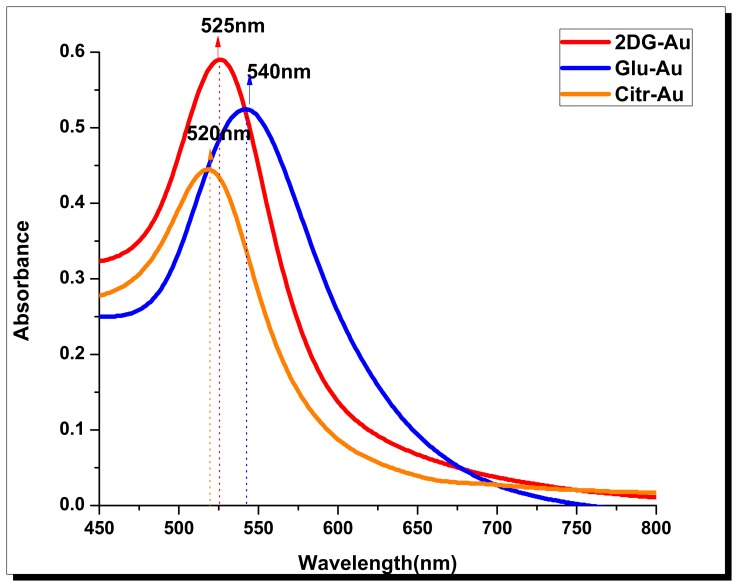
UV-visible absorption spectrum of AuNPs.A UV-visible absorption spectrum of glucose-AuNps showing SPR peak at 540 nm; B Citrate-AuNps showing SPR peak at 520 nm; C 2DG-AuNps showing SPR peak at 525 nm.